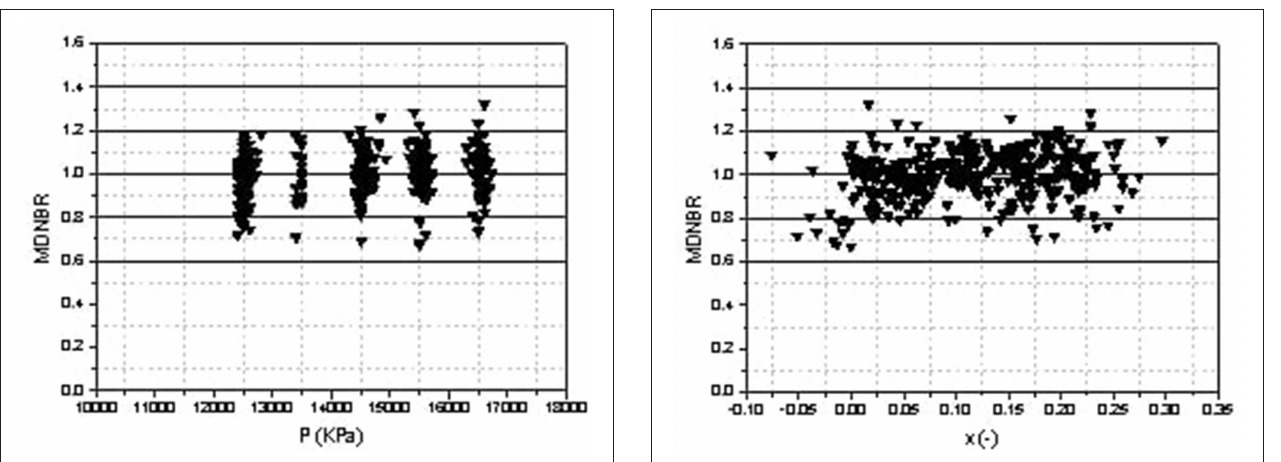
FIGURE 9 | Variation of Predicted MDNBRs with quality.